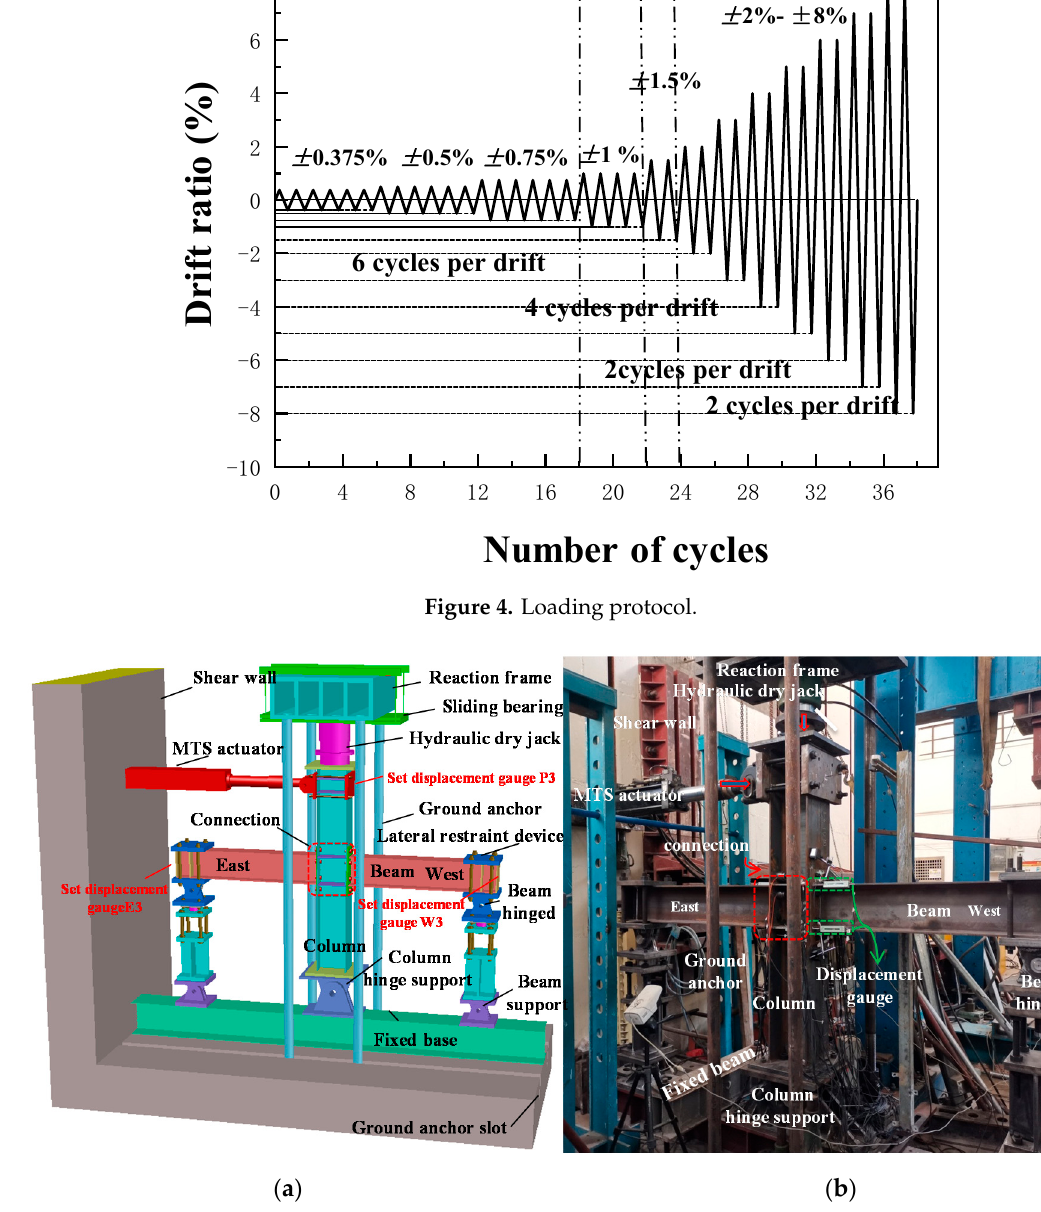
Figure 5. Test setup: ( a ) Schematic of test setup; ( b ) Laboratory test setup.